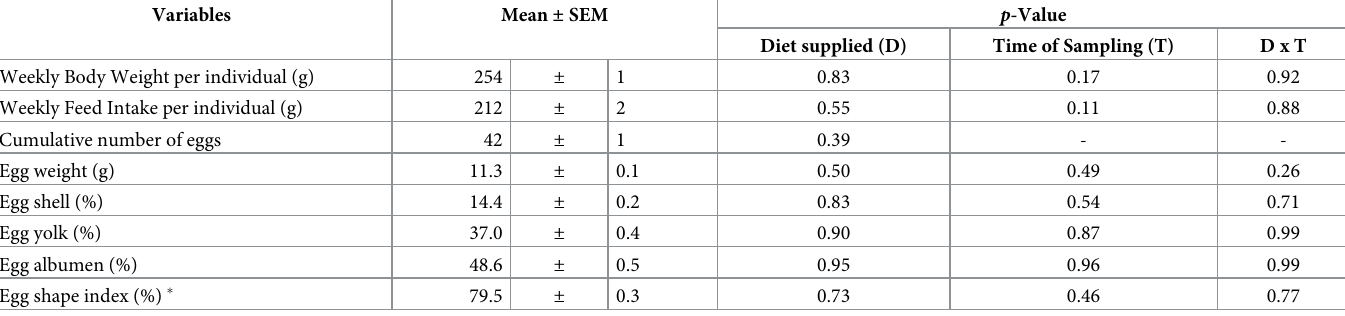
Table 2. Overall mean values ( ± SEM) and statistical information regarding performance related variables from female quail fed with control diets or supplemented with thymol (Diet supplied) over five time points (Time of sampling).